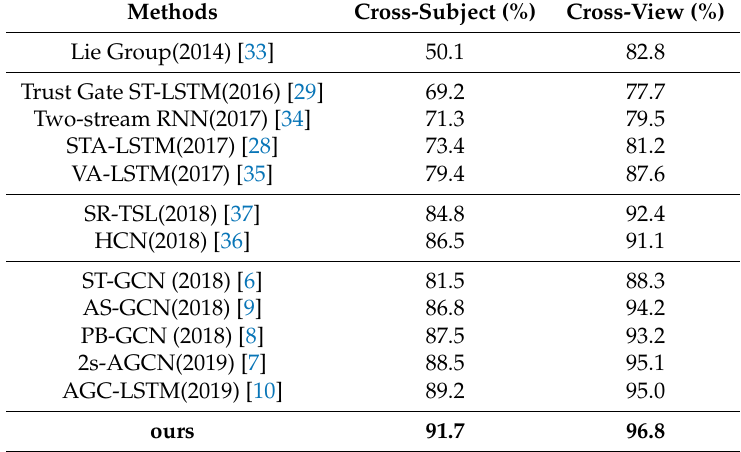
Table 5. Comparisons of the validation accuracy with state-of-the-art methods on the NTU- RGBD